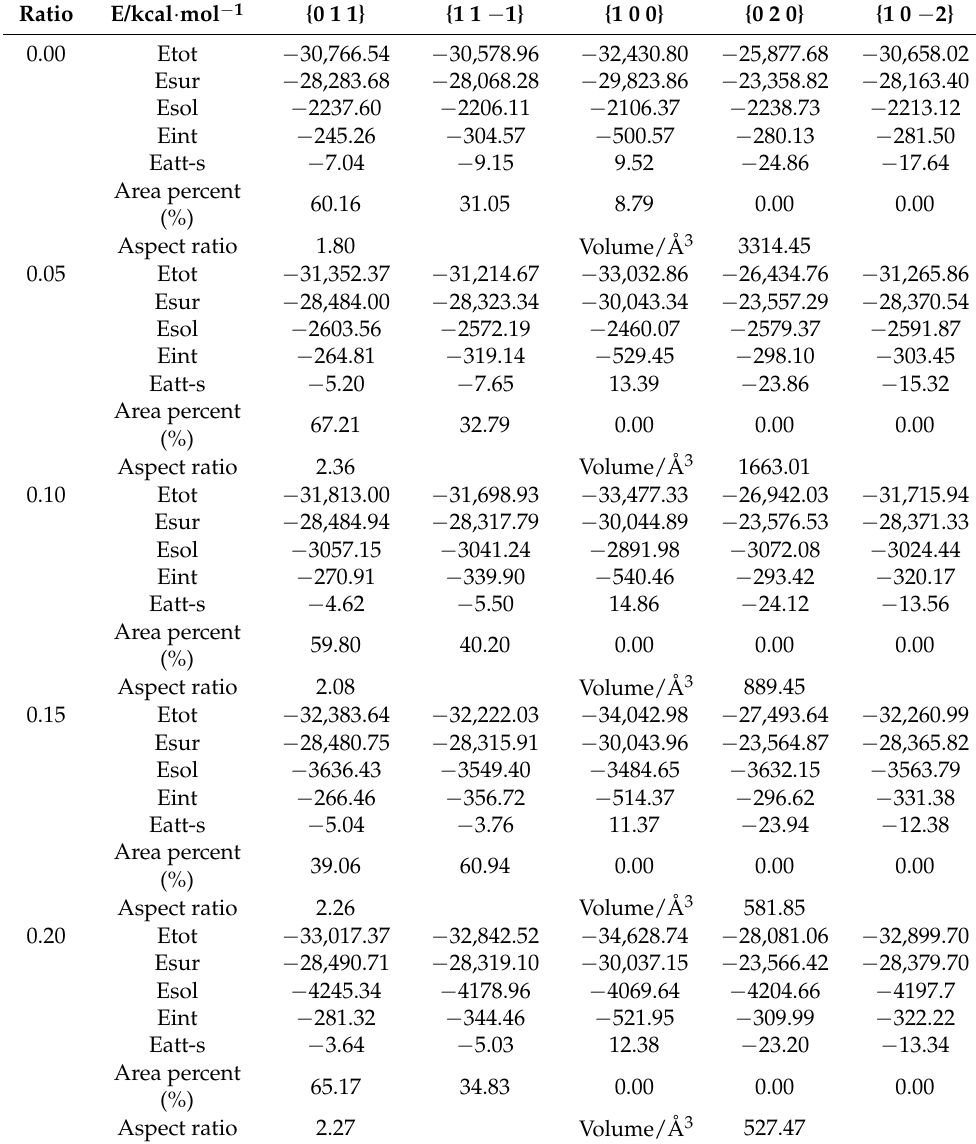
Table 4. Interaction energies and crystal habits of β -HMX in DMSO–water system with different mass fractions of water at 298